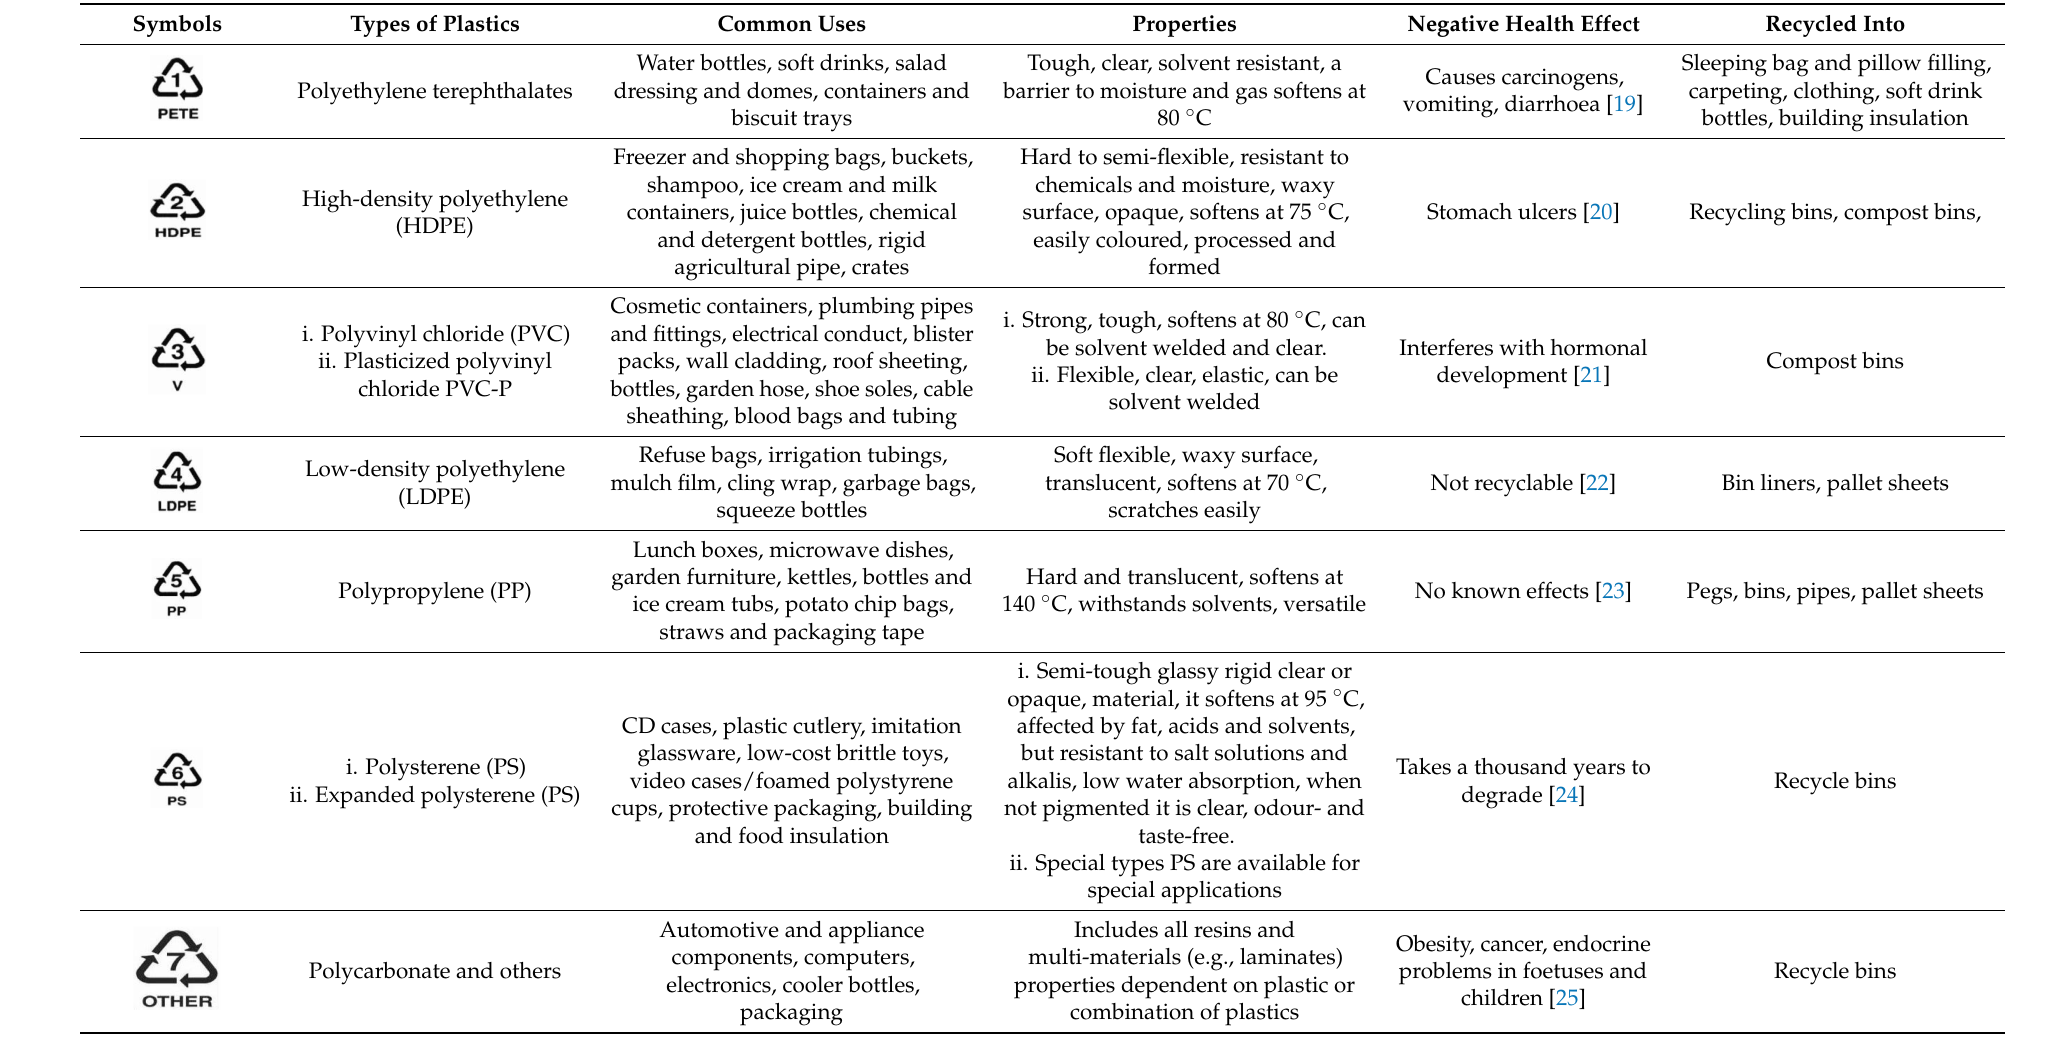
Table 1. Types of plastics, their properties and common